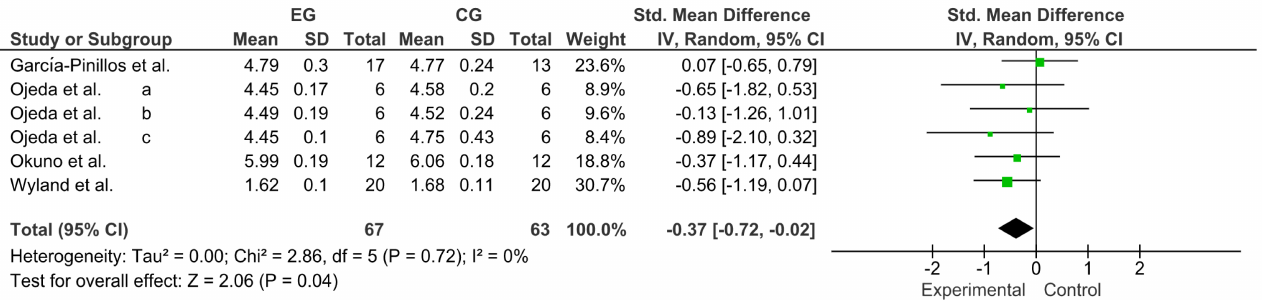
Figure 5. Forest plot comparing the effects of training with VR on throwing speed [40,47].